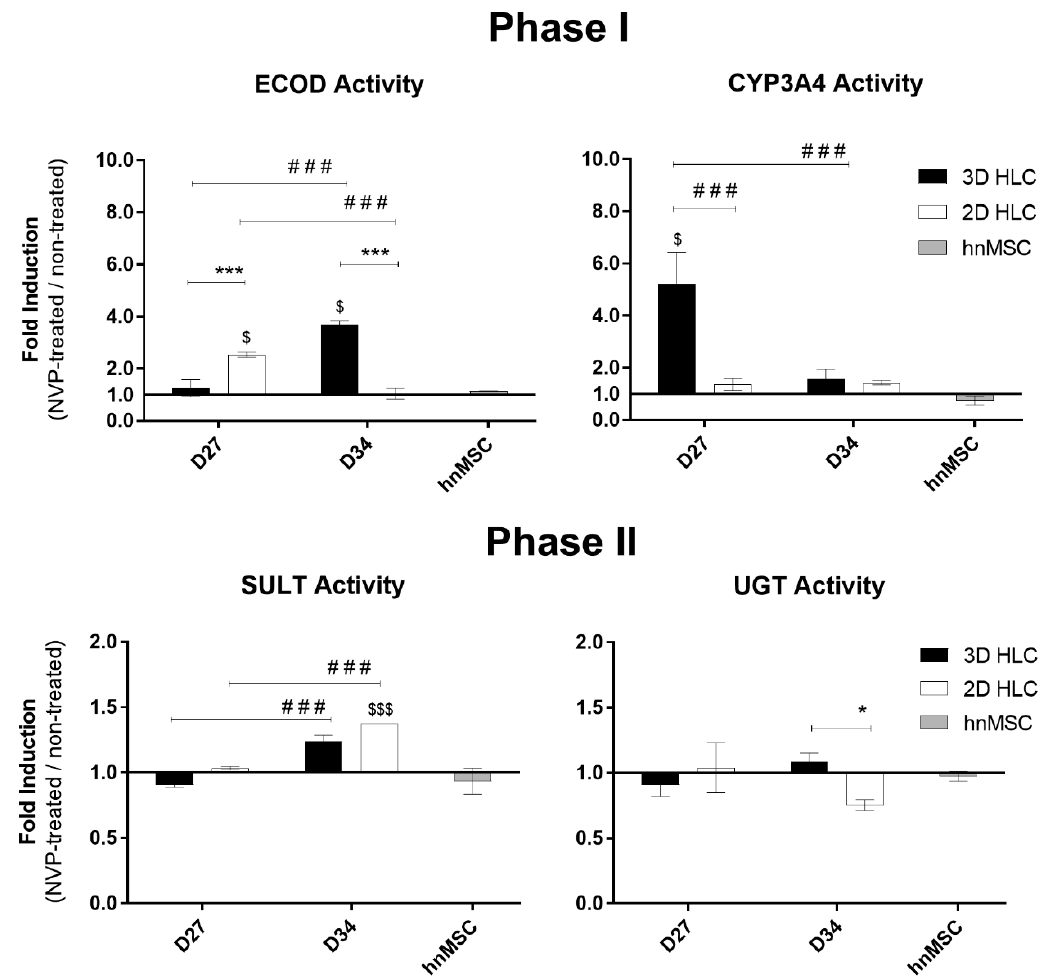
Figure 3. Phase I and Phase II enzymatic induction in 3D- and 2D-HLCs after 3 (D27) and 10 days (D34) of NVP treatment. The data for hnMSC, cultured in monolayer and exposed to NVP for 3 days, are presented as negative control. * p < 0.05 and *** p < 0.001 relative to 2D-HLCs, $ p < 0.05 and $$$ p < 0.001 relative to non-treated and ### p < 0.001 relative to D27 of culture. The data (Mean ± SD, n = 3) are represented as fold induction in NVP-treated cells relative to non-treated cells.